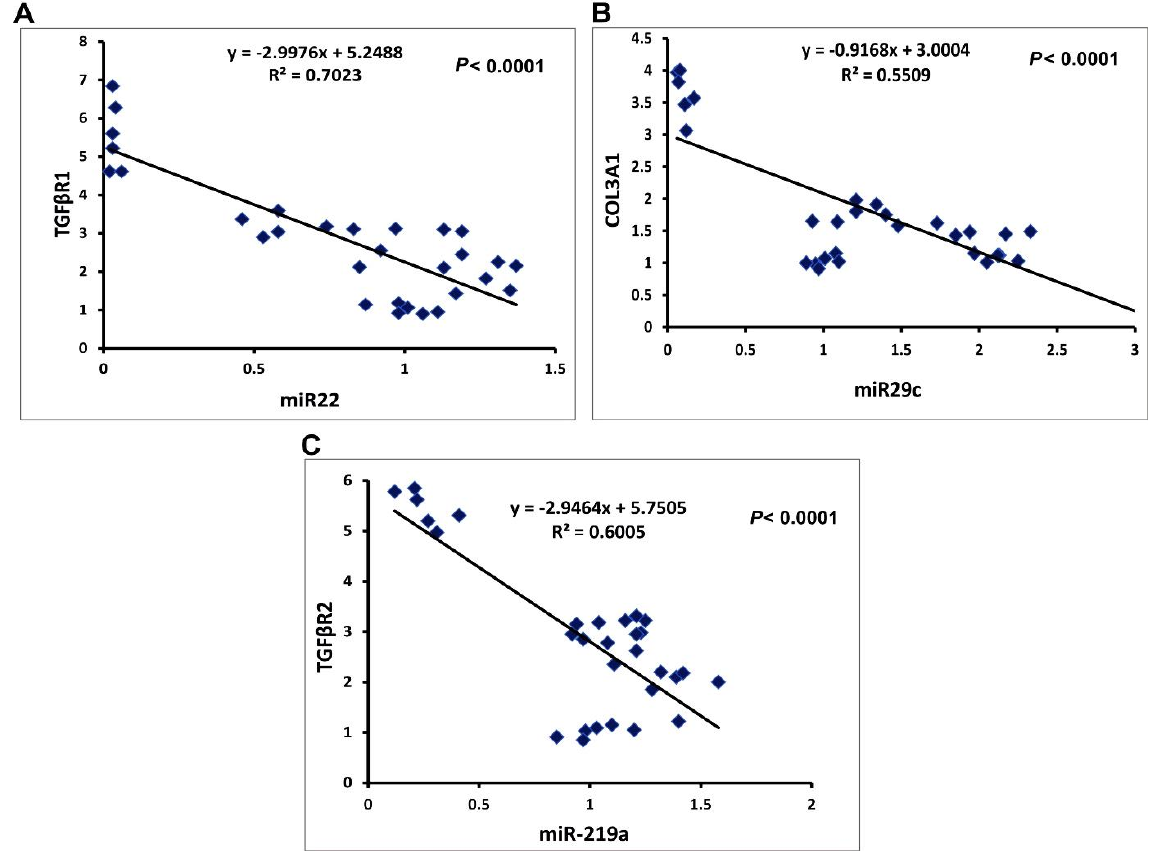
Figure 9. The Pearson significant correlations between miRNA genes and their target genes in the hepatic of rats treated with different study groups: ( A ) correlation curve between miR-22 and TGF β R1 expression; ( B ) correlation curve between miR-29c and COL3A1expression; ( C ) correlation curve between miR-219a and TGF β R2 expression.